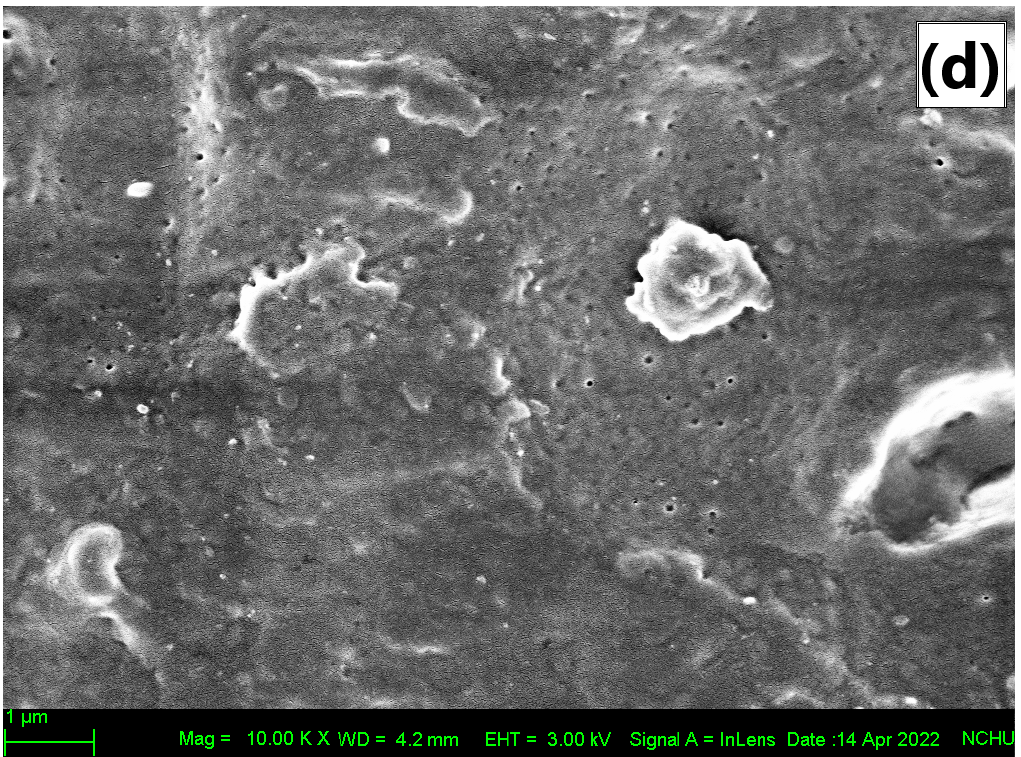
Figure 2. Surface characterization of plasma-treated LDPE film coated with different type of emulsion ( a ) Control ( b ) CE 6% ( c ) NE 6% and ( d ) PE 6% observed under 10,000× magnification.